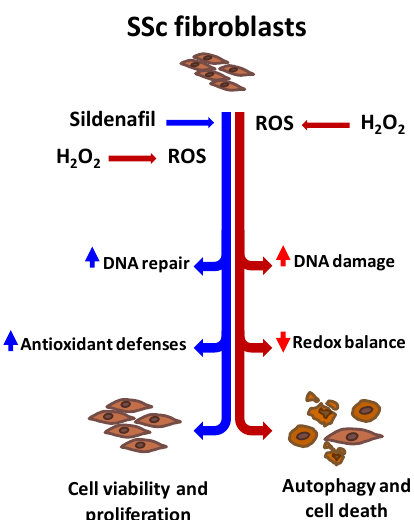
Figure 6. Reactive oxygen species (ROS) resulting from pro-oxidant exposure (H 2 O 2 , red arrows) increase the DNA damage and affect the redox homeostasis in systemic sclerosis fibroblasts (SSc). As a consequence, cells undergo cell death by autophagy. In the same pro-oxidant environment, the presence of the phosphodiesterase type 5 inhibitor sildenafil (blue arrows) counteracts the negative effects of ROS on cell viability and proliferation, inhibiting the activation of the autophagic pathway and modulating the activity of specific enzymes involved in redox homeostasis.